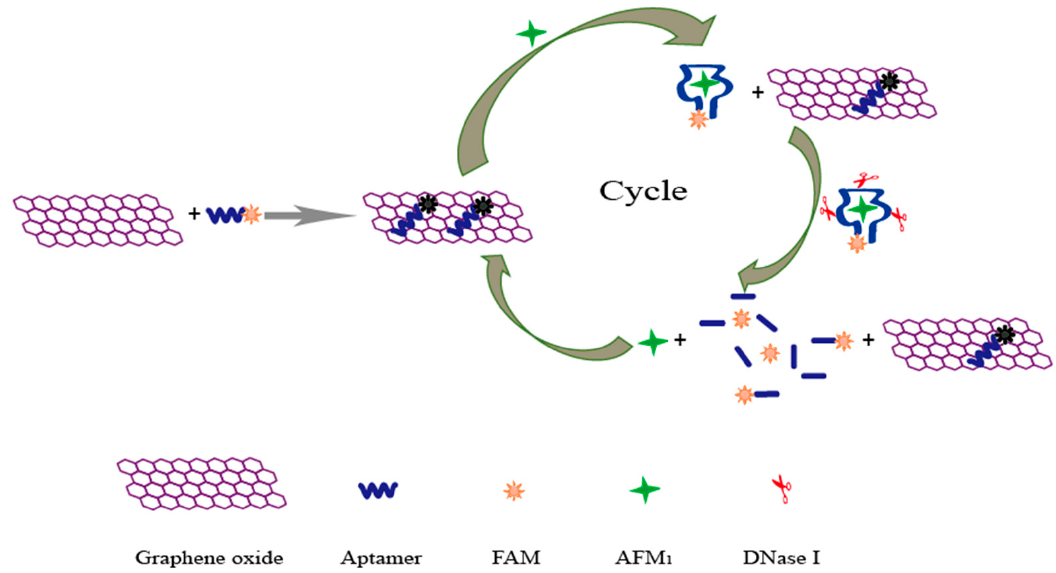
Figure1. IllustrationoftheaptasensorforthedetectionofaflatoxinM 1 (AFM 1 ). FAM:carboxyfluorescein. Figure 1. Illustration of the aptasensor for the detection of aflatoxin M 1 (AFM 1 ). FAM: